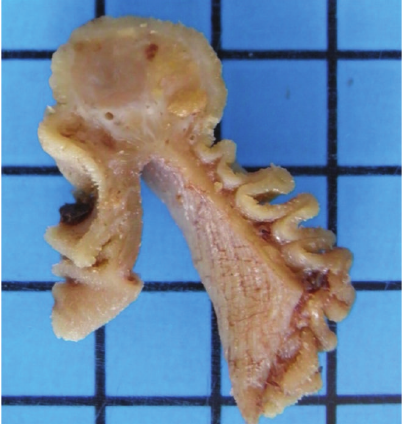
Figure 2: Fixated gross section of the polypoid submucosal tumor protruding the mucosa.